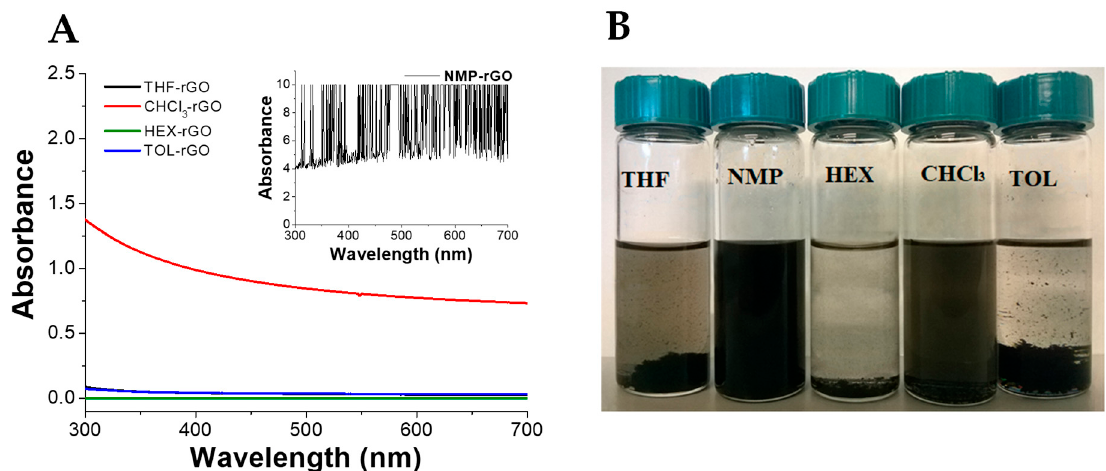
Figure 2. ( A ) UV–vis spectra and ( B ) optical pictures of rGO dispersed in organic solvent after preparation. Tetrahydrofuran (THF), 1-methyl-2-pyrrolidone (NMP), hexane (HEX), chloroform (CHCl 3 ), and toluene (TOL). For all dispersions, 5 mg of rGO in 10 mL of solvent.